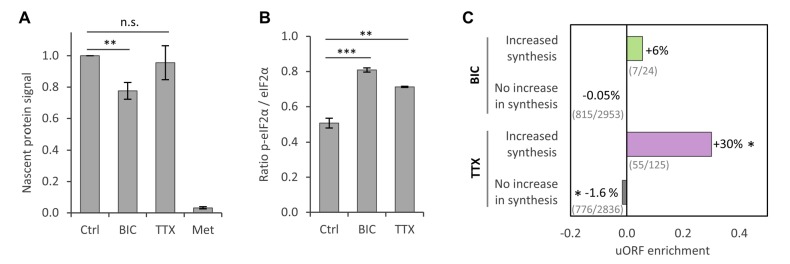
Regulation of protein synthesis during homeostatic scaling.(A) Quantification of the biotin-derived nascent protein signal via western blot. Error bars represent the standard error of the mean (SEM). N = 5 biological replicates. Protein synthesis was significantly reduced in BIC-treated hippocampal cultures compared to untreated controls (paired t-test, p<0.05), whereas the change in protein synthesis was not statistically significant for TTX-treated hippocampal cultures. (B) Quantification of phosphorylated as well as unmodified eIF2α via western blot. Error bars represent the SEM. N = 3 biological replicates. Phosphorylation of eIF2α at Ser51 was significantly increased after 24 hr of treatment with BIC (unpaired t-test, p-value<0.001) and TTX (unpaired t-test, p-value<0.01). (C) uORF enrichment analysis for the sets of proteins that do or do not show increased protein synthesis during BIC-induced down-scaling or TTX-induced up-scaling. uORF-containing genes are significantly over-represented in the group of proteins that showed increased synthesis during TTX treatment (hypergeometric test, p<0.05) and significantly under-represented in the group of proteins that did not show increased synthesis during TTX treatment (hypergeometric test, p<0.05). Numbers of uORF-containing transcripts per gene subset are shown in brackets. The rat genome was used as reference.